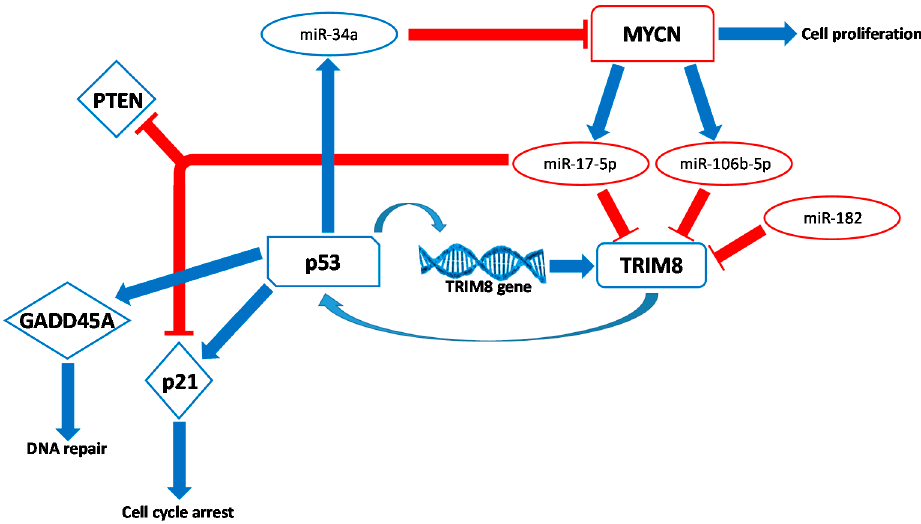
Figure 3. Schematic representation of the tumour suppressor network involving TRIM8. Following cellular stress, the p53 tumour suppressor protein transactivates TRIM8 gene, which in turn stabilizes p53, promoting the transcription of p53 target genes involved in cell proliferation arrest ( p21 ), DNA repair ( GADD45A ), and the suppression of the MYCN oncogenic activity by miR-34a. Without the inhibitory effect of miR-34a, MYCN promotes the transcription of miR-17-5p and miR-106b-5p, which target TRIM8 mRNA, promoting its degradation. Moreover, in anaplastic thyroid cancer, miR-182 targets TRIM8 mRNA, maintaining low levels.